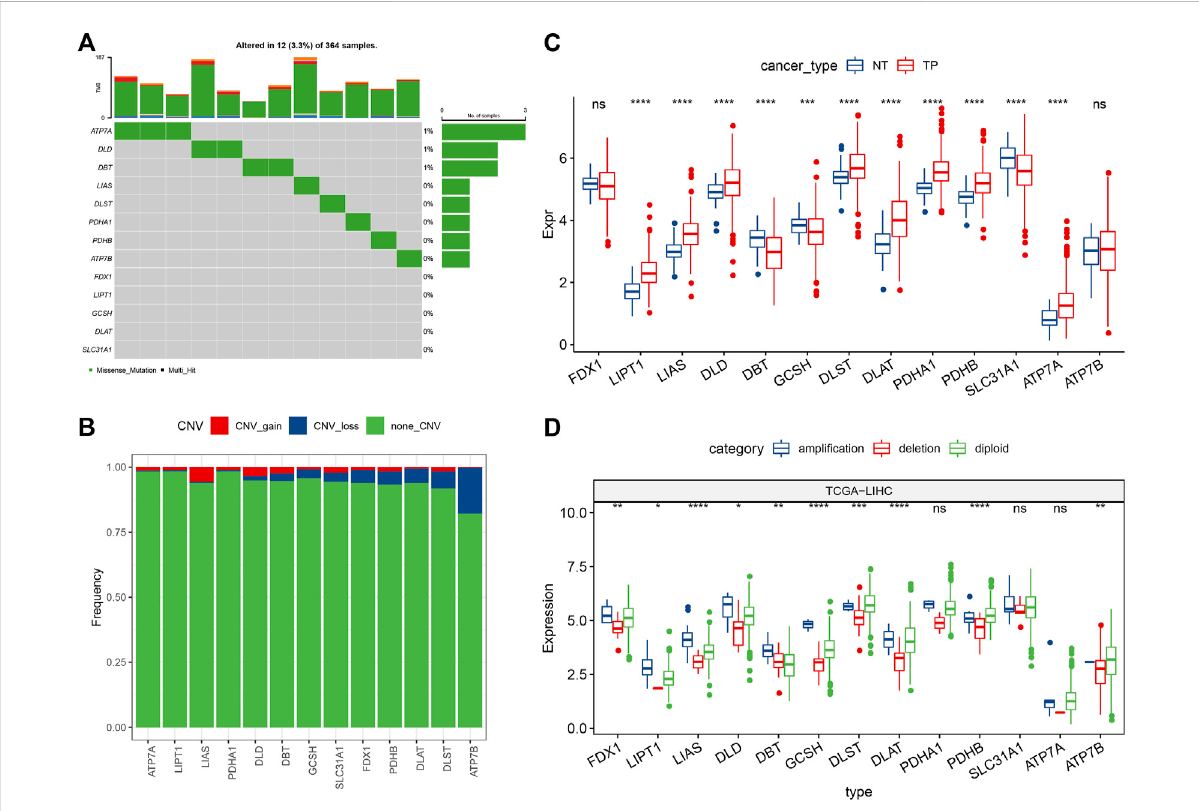
FIGURE 1 Mutation map and expression characteristics of cuproptosis-related genes in liver cancer. (A) Mutation map of cuproptosis-linked genes in the primary tumor samples; (B) CNVs of cuproptosis-linked genes in the primary tumor samples. Vertical axis indicates the percentage of CNV types of cuproptosis-related genes; (C) The differences of gene expression levels between different CNV types in primary tumor samples; (D) Differential analysisoftranscriptionalexpressionlevelsofcuproptosis-linkedgenesinprimarytumorandadjacentnormaltissuesamples.Log2(expression) was selected in C and D. ns, not signi fi cant. * p < 0.05, ** p < 0.01, *** p < 0.001, **** p <